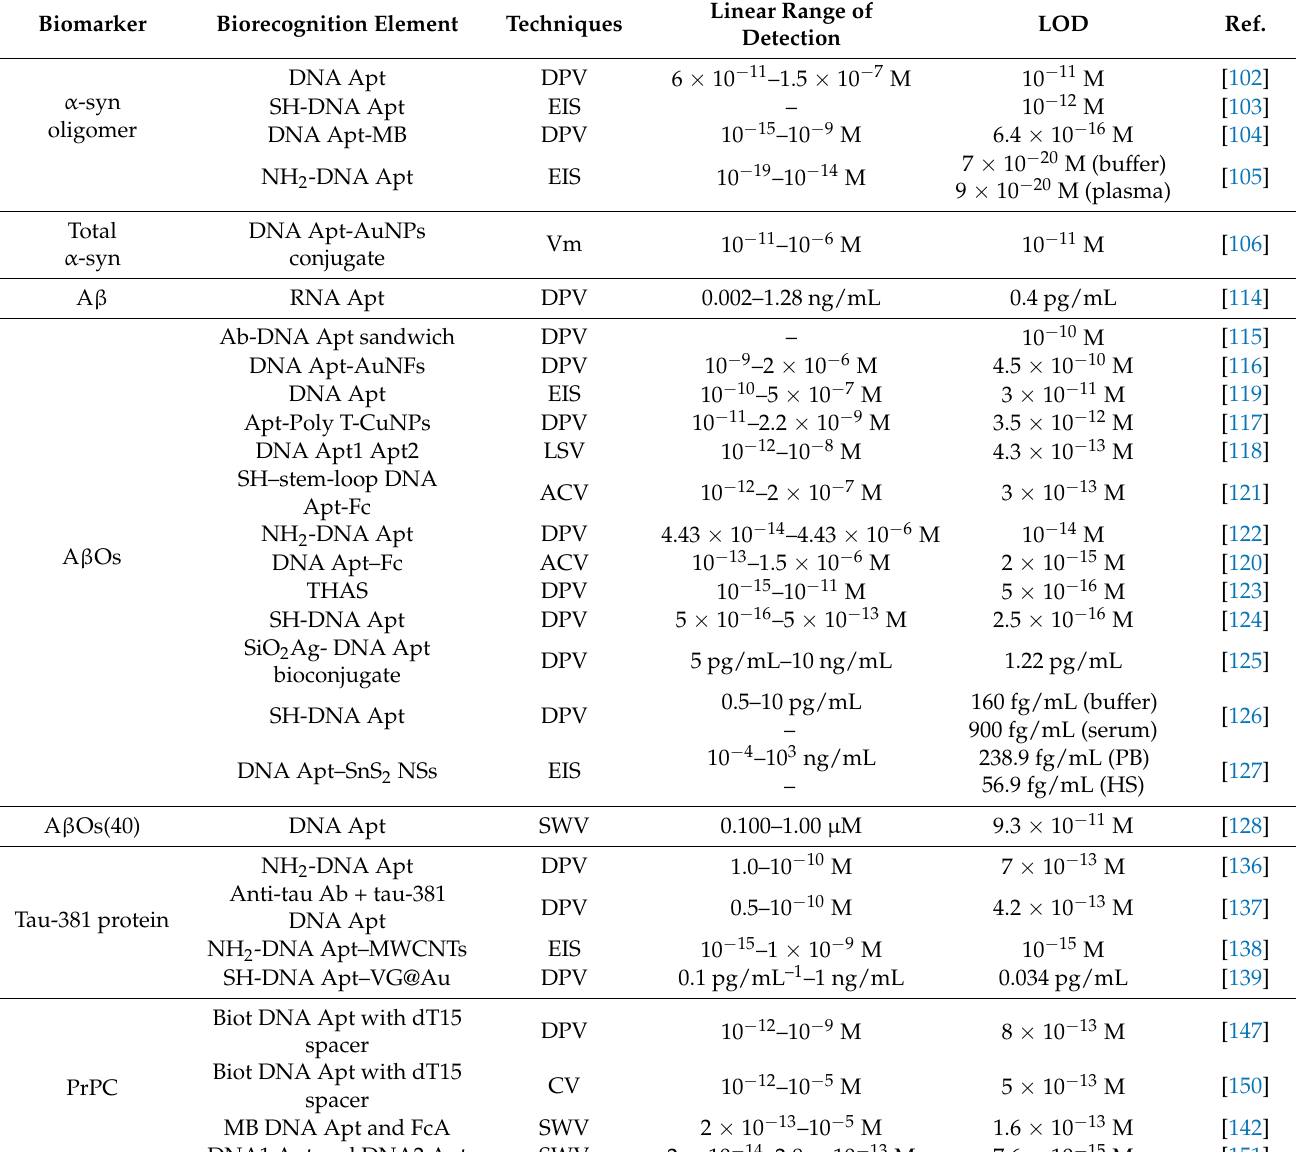
Table 1. Specifications of electrochemical aptasensors for the detection of ND